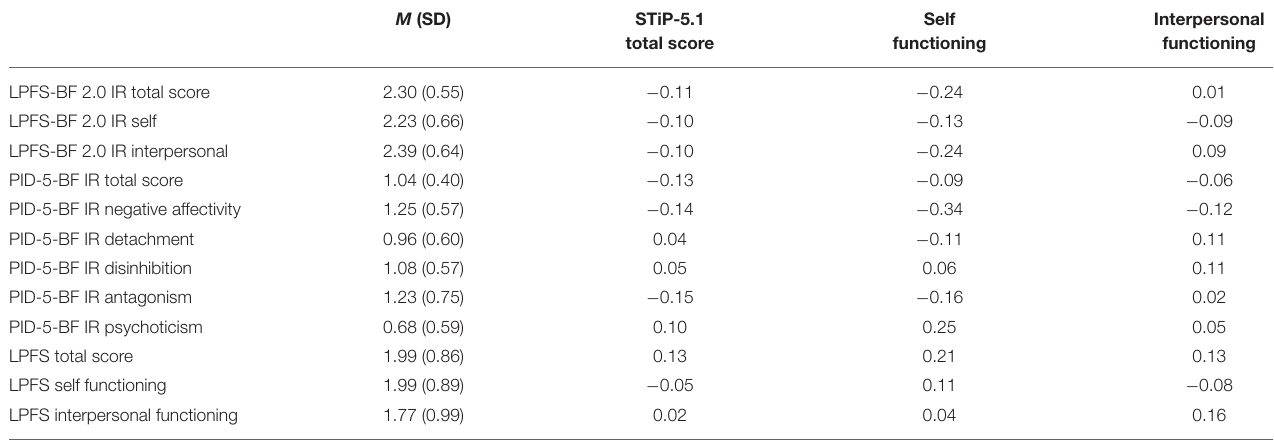
TABLE 4 | Means and standard deviations of informant-report (IR) measures and correlations of expert-rated personality functioning with informant-report (IR) measures of personality functioning ( N =